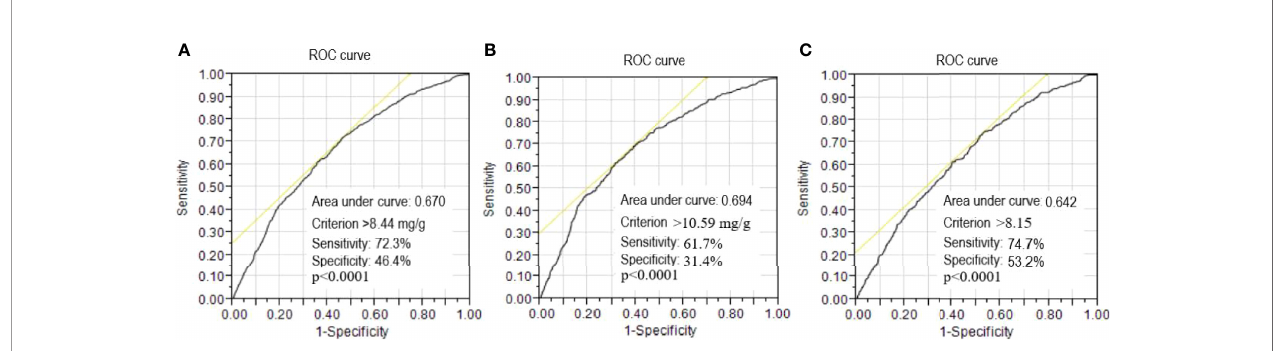
FIGURE 1 | Receiver operating characteristic (ROC) curves of urinary albumin/creatinine ratio to detect the risk of progression to chronic kidney disease (CKD). A threshold value of >8.44 mg/g was associated with the risk of CKD progression with a sensitivity of 72.3% and speci fi city of 46.4% for all patients (A) . A threshold value of >10.59 mg/g was associated with the risk of CKD progression with a sensitivity of 61.7% and speci fi city of 31.4% for the male patients (B) . A threshold value of >8.15 mg/g was associated with the risk of CKD progression with a sensitivity of 74.7% and speci fi city of 53.2% for the female patients (C) .